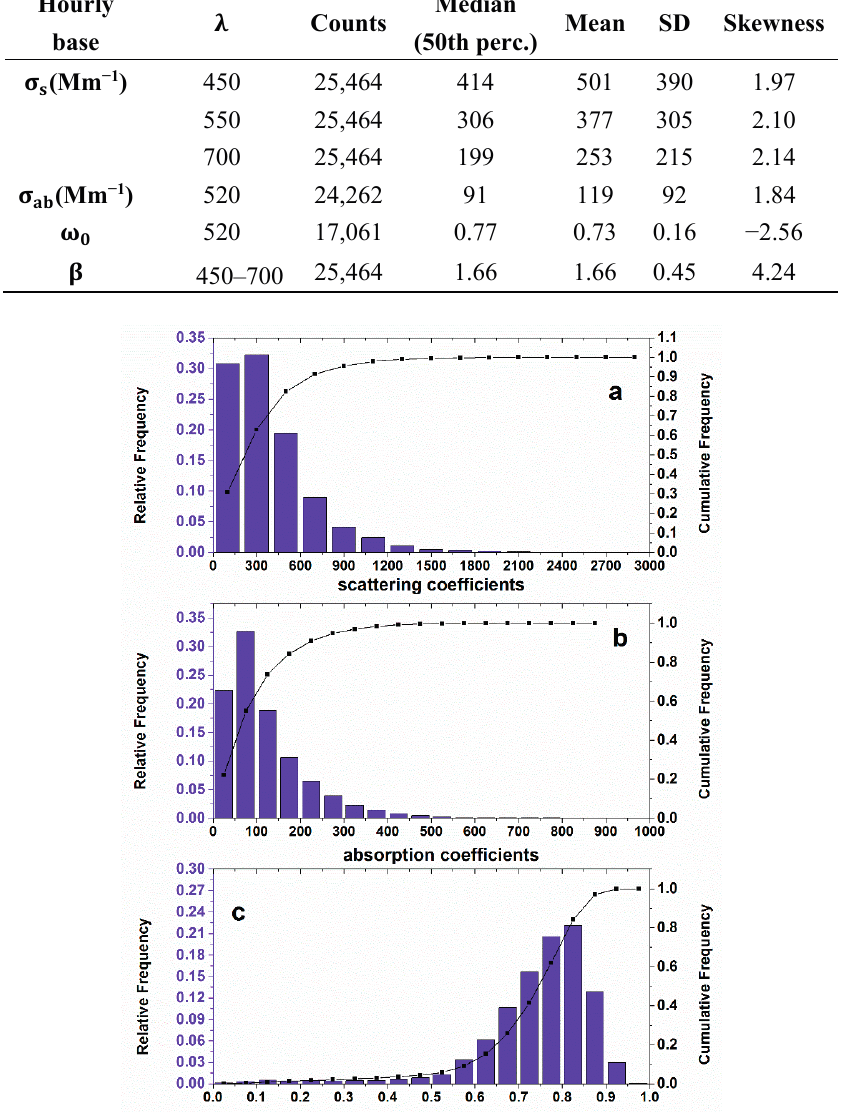
); ( b ) aerosol absorption coefficients ( σ (cid:2929)